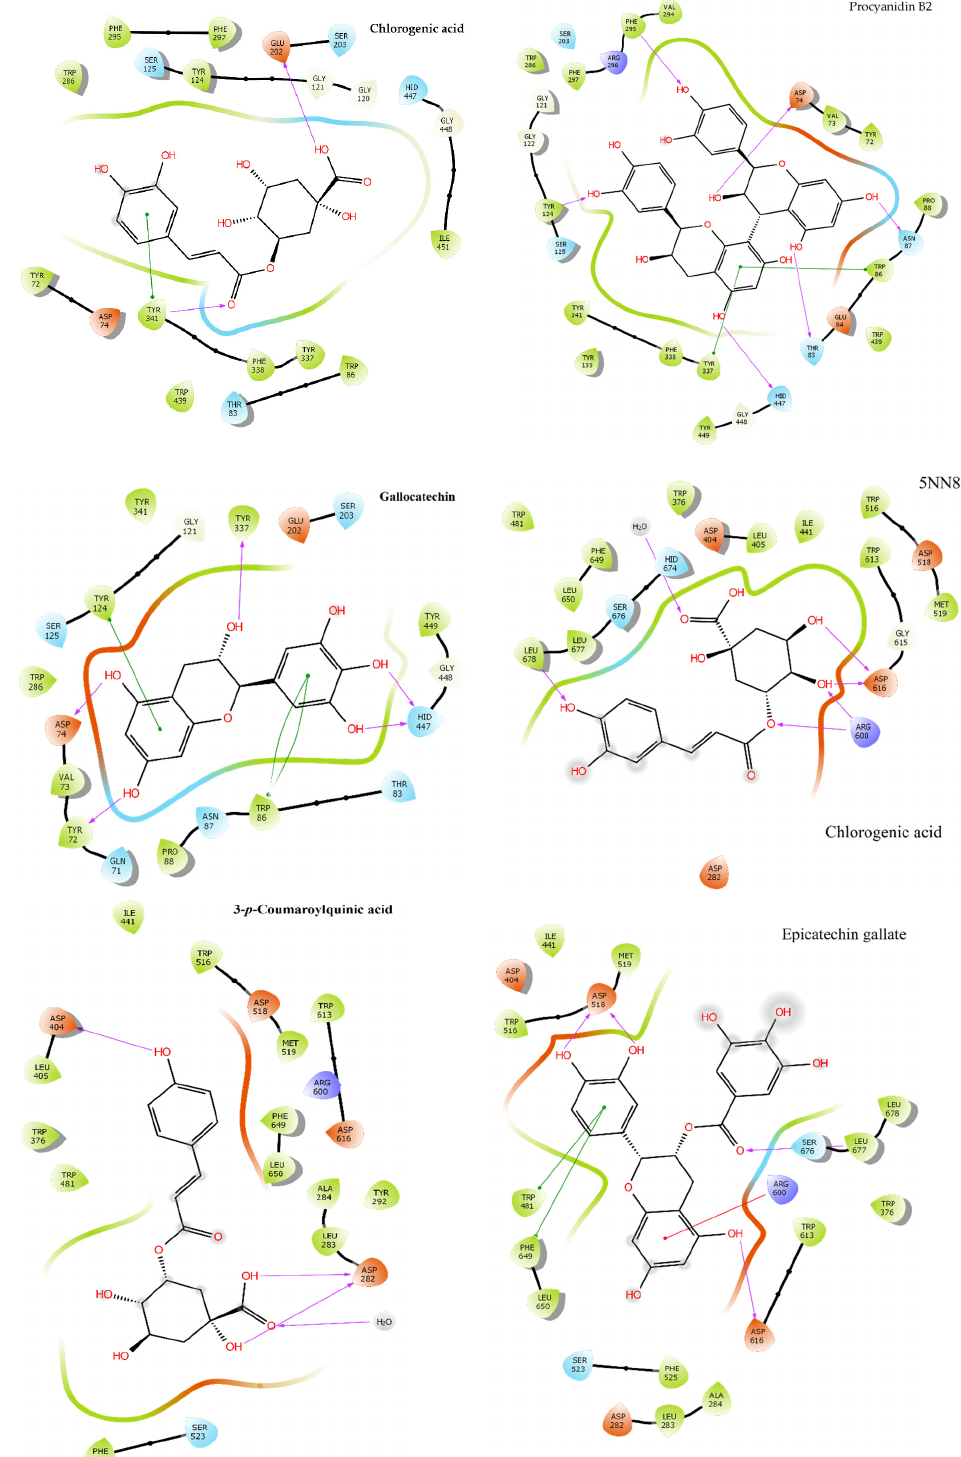
Figure 5. The estimated binding geometry of chlorogenic acid, procyanidin B2, gallocatechin in AChE and chlorogenic acid, 3- p -coumaroylquinic acid and epicatechin gallate in α -glucosidase. All hydrogen bonds are presented in pink color with single arrows while active side residues are named with three letters.